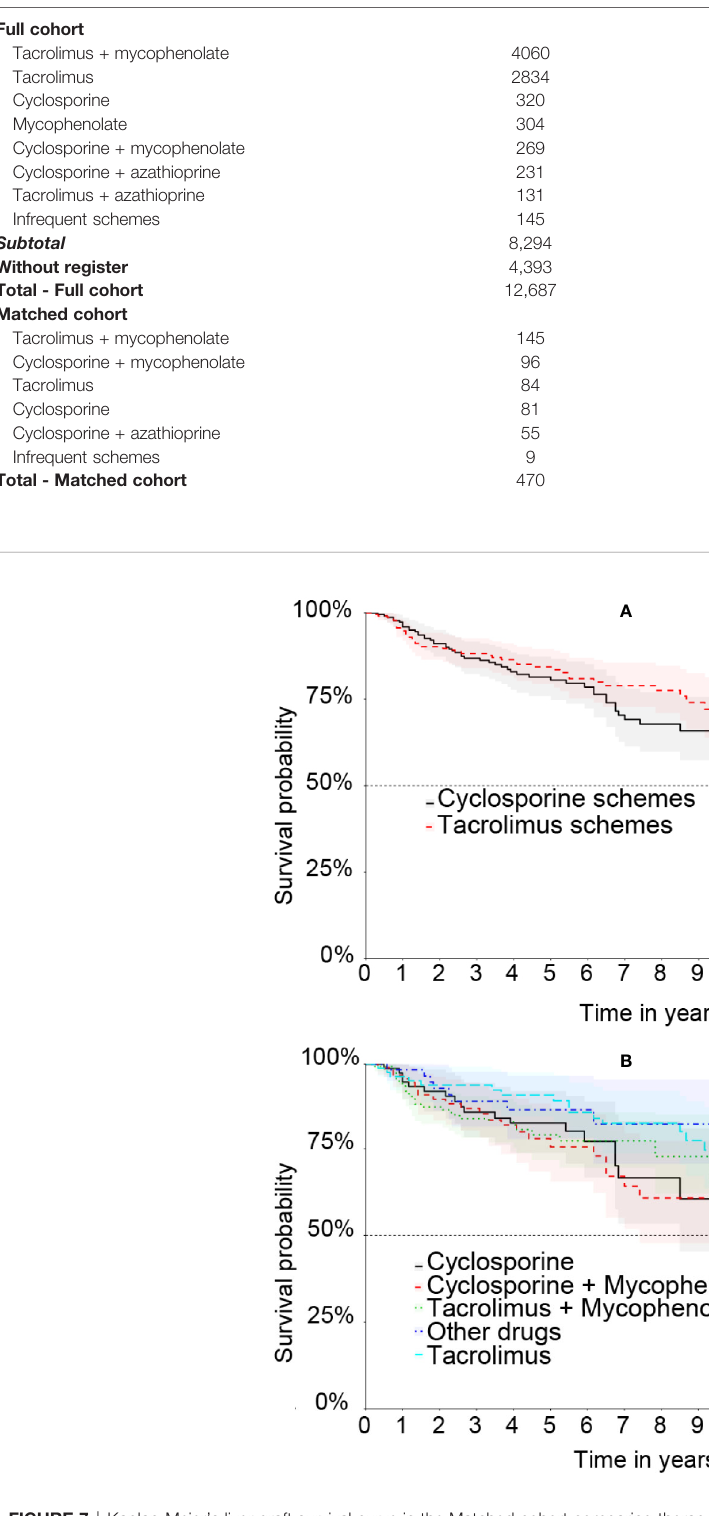
FIGURE 7 | Kaplan-Meier ’ s liver graft survival curve in the Matched cohort comparing therapeutic regimens: (A) Treatment based on cyclosporine or tacrolimus. (B) The speci fi c therapeutic schemes.